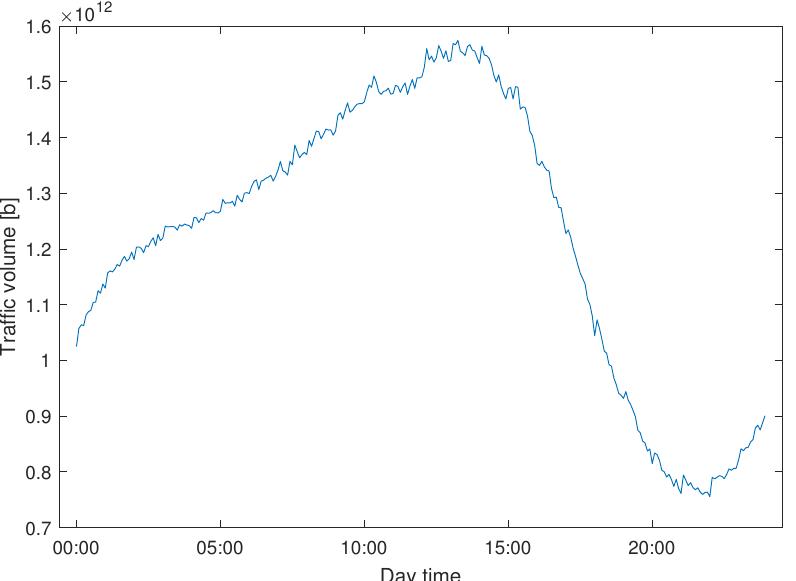
Figure 4. SIX dataset presentation: traffic observed on 1 January 2021.